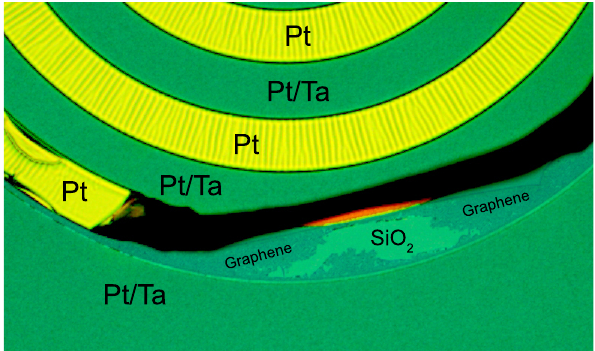
Figure 5. Optical micrograph of a wafer with lift-off patterned Ta structures, after the CVD graphene growth and before the Pt etch process step. Whereas the 50 nm Pt on top of 30 nm Ta is forming a flat surface, with Ta enhancing Pt adhesion, the intermediate regions with Pt show signs of weak adhesion (surface corrugation) and delamination. In a region where the Pt is delaminated, CVD graphene is observed on the SiO 2 , that corresponds to the graphene in Figure 4 after Pt